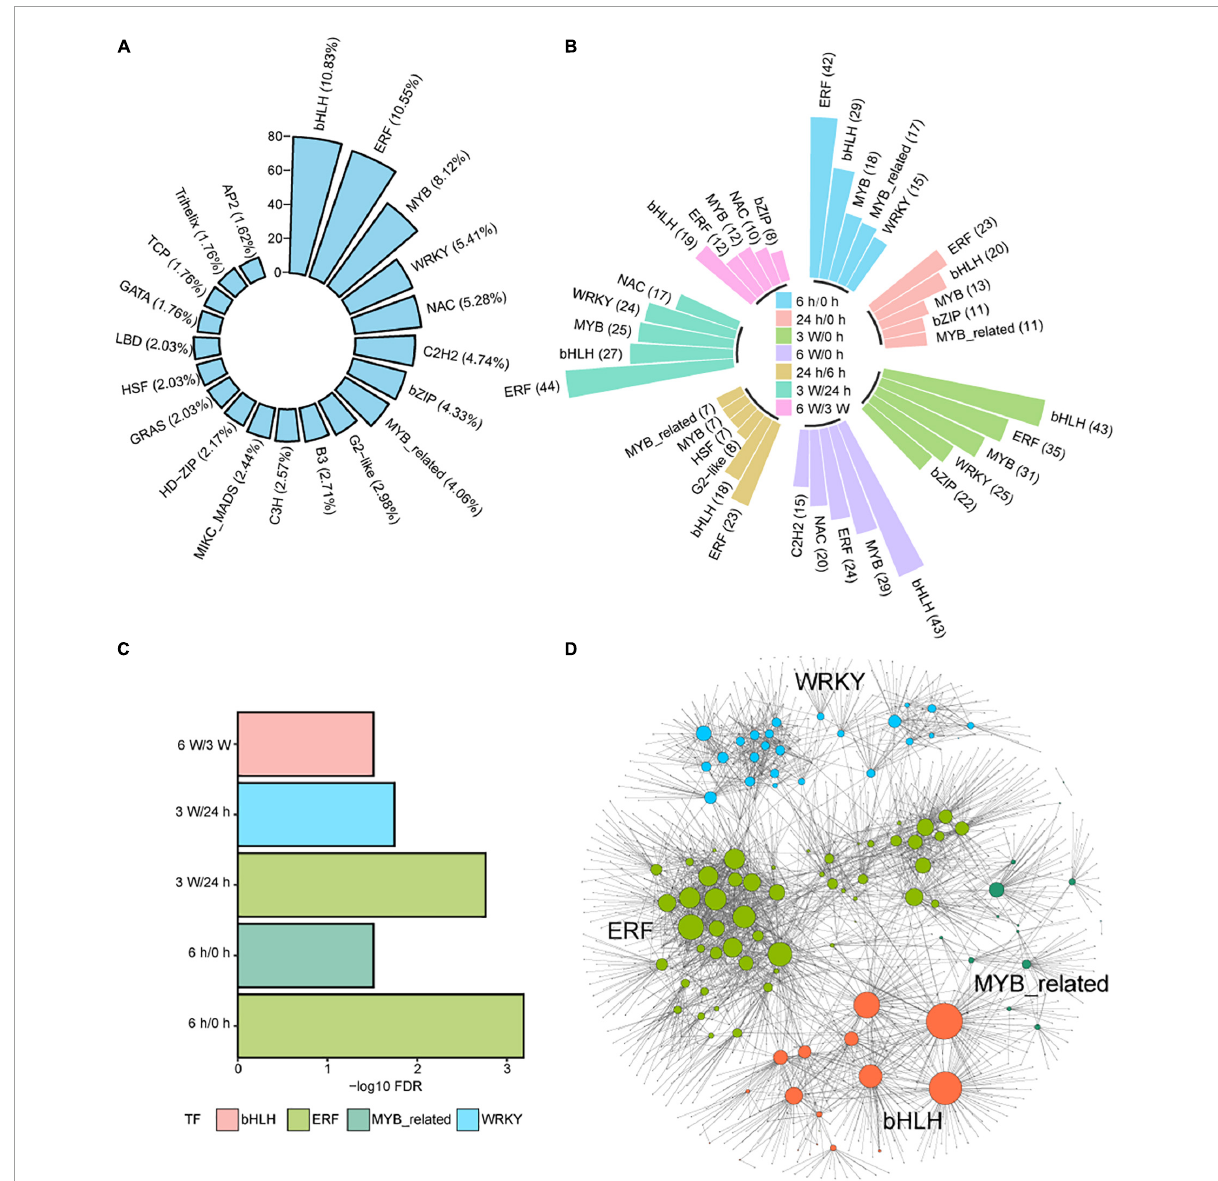
FIGURE6 The regulatory networks of differently expressed TFs during cold treatment. (A) Bar plot showing the distribution of the top 20 differently expressed TFs in total DEG and DAS genes. (B) Bar plot showing the distribution of the top 5 of differently expressed TFs in DEG and DAS genes at each time point. (C) Enrichment analysis of TF DNA binding motifs within the promoter regions of DEG and DASs genes at each time point. (D) Predicted regulatory networks based on enriched TFs and their potential targeted genes in DEG and DAS genes. Different colors represent different TFs and the big dots represent TFs. The detailed information was showing in Supplementary Table 18